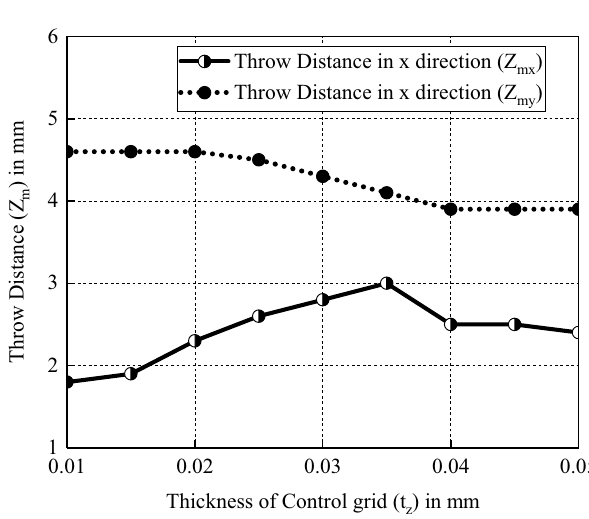
Figure 12. Variation of throw distances in both x and y directions with t z